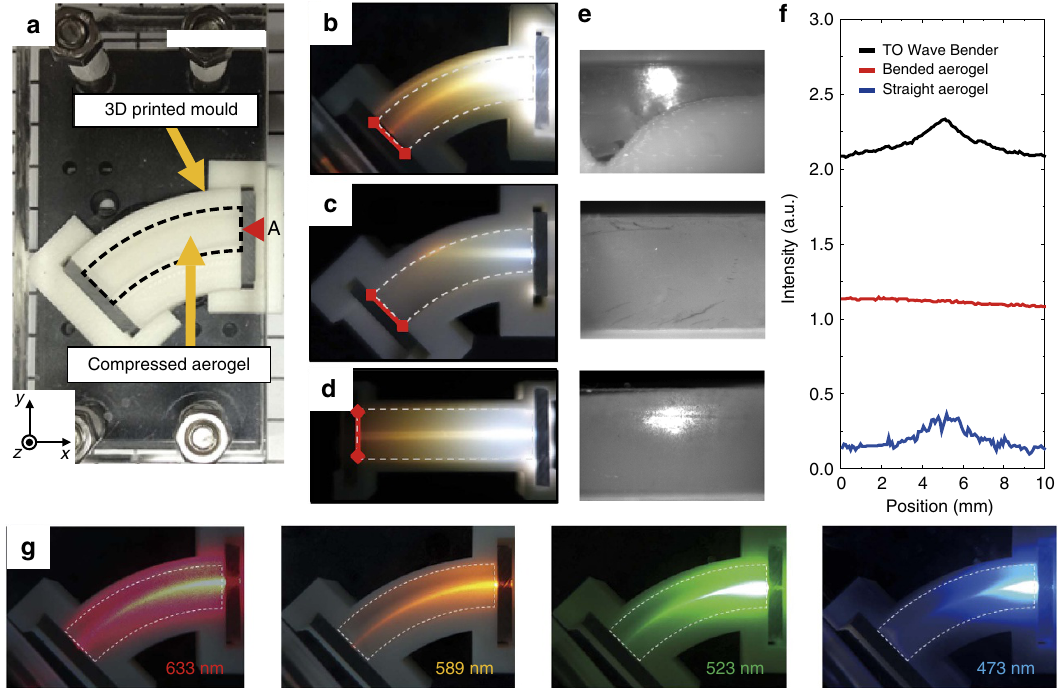
Figure 4 | Experimental demonstrations of a macroscale visible wave bender. ( a ) A photograph of the wave bender sample. The size of the scale bar, 20mm. With a 3D printed pressing mould for wave bender, we compressed the aerogel (dashed region), resulting in the designed distribution of the compression ratio and the effective refractive index for the transformation-optics (TO) wave bender. The aerogel prepared for the wave bender sample with 45 (cid:2) bending has the following parameters: outer radius R 0 ¼ 46mm, inner radius r 0 ¼ 37mm, and thickness t 0 ¼ 5mm. The light beams are incident on the red spot A from the right. ( b ) A collimated white-light beam from a solar simulator is incident and propagates along the curved wave bender, satisfying the TO design. For reference, light propagates in a straight line inside ( c ) a 45 (cid:2) -bend, and ( d ) a straight homogeneous aerogel chunk, without mechanical deformation. ( e ) The cross-sectional images and ( f ) intensity profiles of light beams at the output surfaces (red edges in b , c , d . ( g ) Various wavelength laser beams (633, 589, 523 and 473nm) are incident and propagate along the curved wave bender, satisfying the TO design.